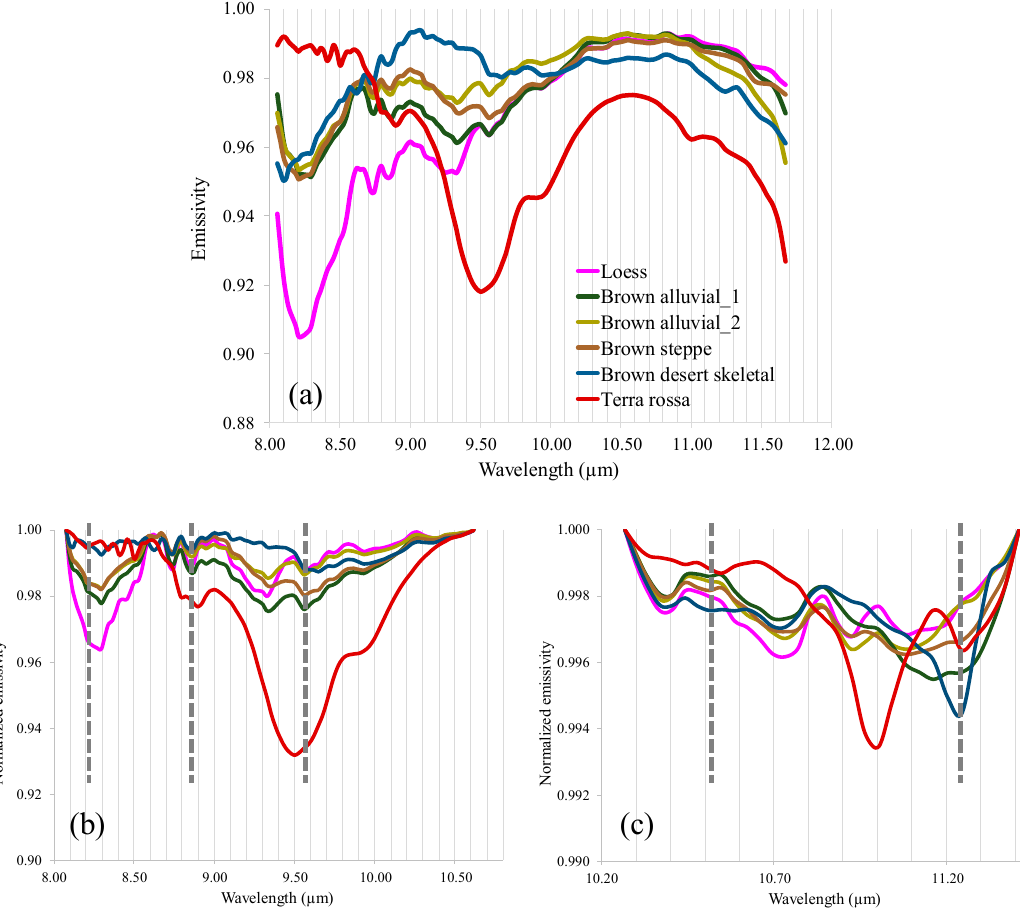
Figure 3. ( a ) Emissivity spectra of soil samples; each spectrum is the average of tens to hundreds of pixels in the image. ( b ) and ( c ) Normalized emissivity spectra (continuum removal normalization in specific spectral ranges [12]), of the soil samples emphasizing mineral-related absorption features of quartz and clay minerals ( b ) and carbonates ( c ), as described in [9]; gray dashed lines indicate the wavelengths mentioned in Equations (1) and (2).